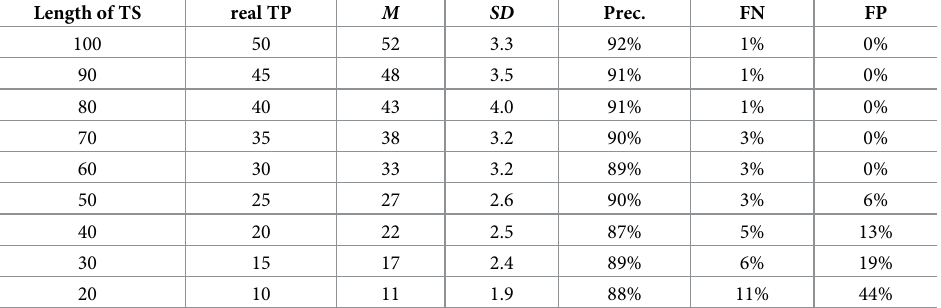
Table 3. Results of the PTDA for time series (TS) of 20 to 100 time points. The mean (M) and the standard devia- tion (SD) of the transition points (TP) of the 300 simulated time series are given along with further indicators of the performance: the precision (Prec.), which gives the rate of identifying a TP within +/- 5 time points around the real TP, and the rates of false negative (FN) and false positive (FP) results. Length of TS